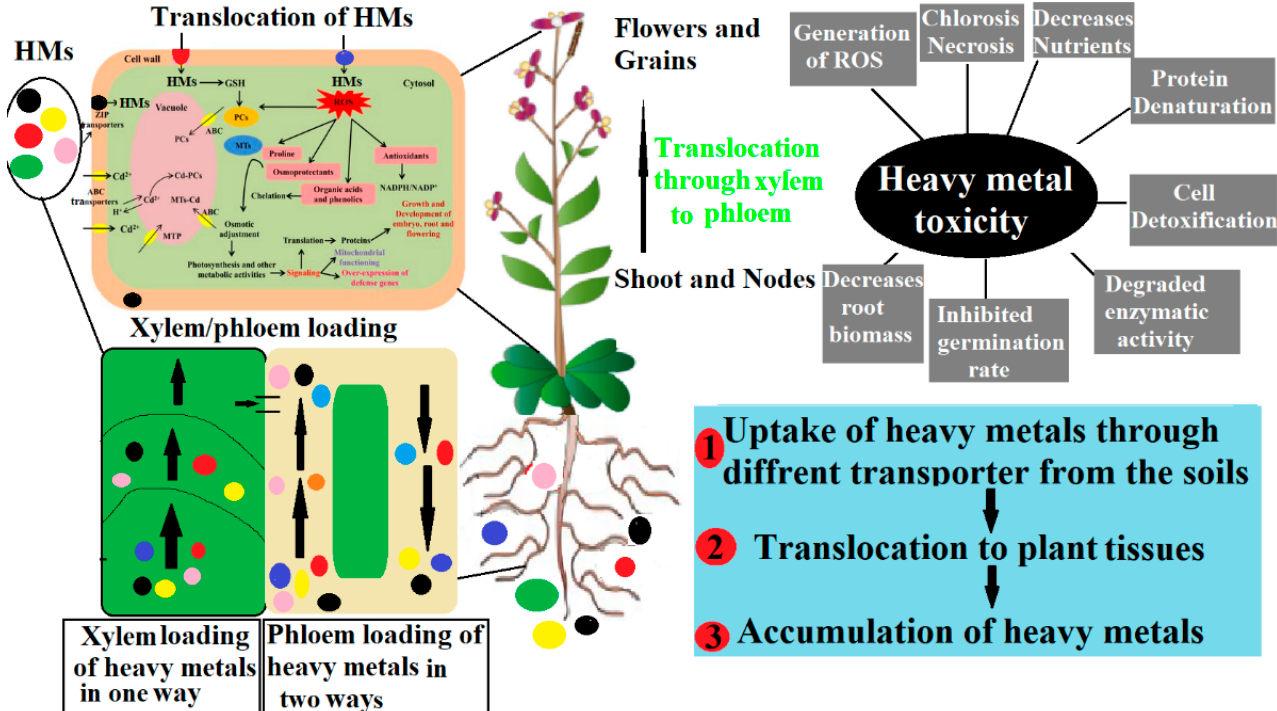
Figure 1. Schematic view of heavy metal (HM) uptake, its translocation towards aerial parts via xylem loading, and its toxicity. The uptake and transport of HMs from the roots to the leaves of plants through apoplastic and symplastic pathways. First HMs enter the plant with the help of various transporters in the roots and are then translocated to different parts. Excessive accumulation of HMs in plant tissues contributes to toxicity with associated effects such as chlorosis, protein denaturation, and decreased plant biomass.